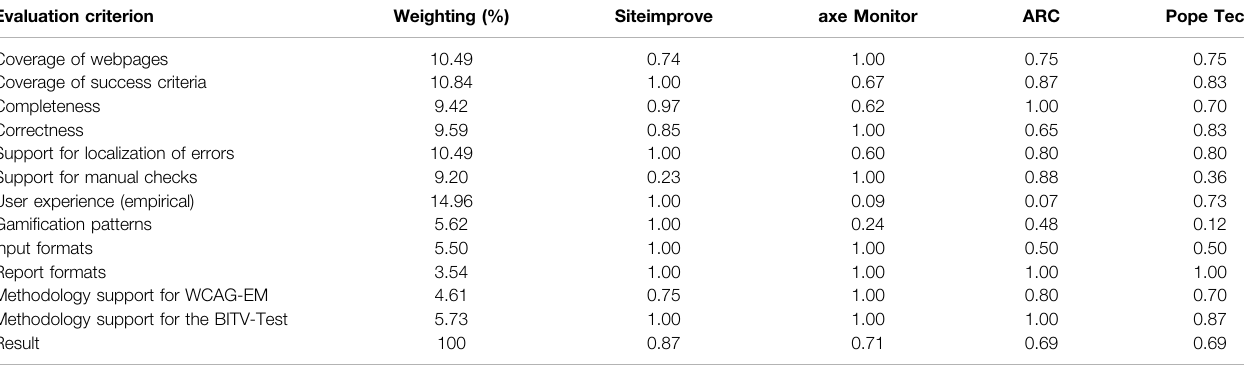
TABLE 1 | Evaluation criteria results of all accessibility monitoring systems (conformance level AAA). 18